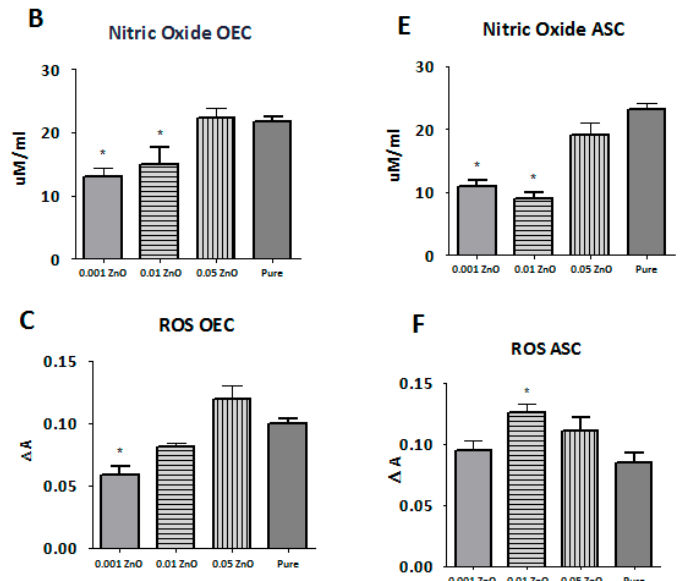
Figure 8. The quantity of superoxide dismutase ( A , D ), nitric oxide ( B , E ) and reactive oxygen species ( C , F ) in olfactory ensheathing cells ( A , B , C ) and adipose stem cells ( D , E , F ) cultured on all tested biomaterials (0.001—PU/PLA 80:20 0.001 ZnO, 0.01—PU/PLA 80:20 0.01 ZnO, 0.05—PU/PLA 80:20 0.05 ZnO, Pure—biomaterial without ZnO); * significantly different from control ( p < 0.05).